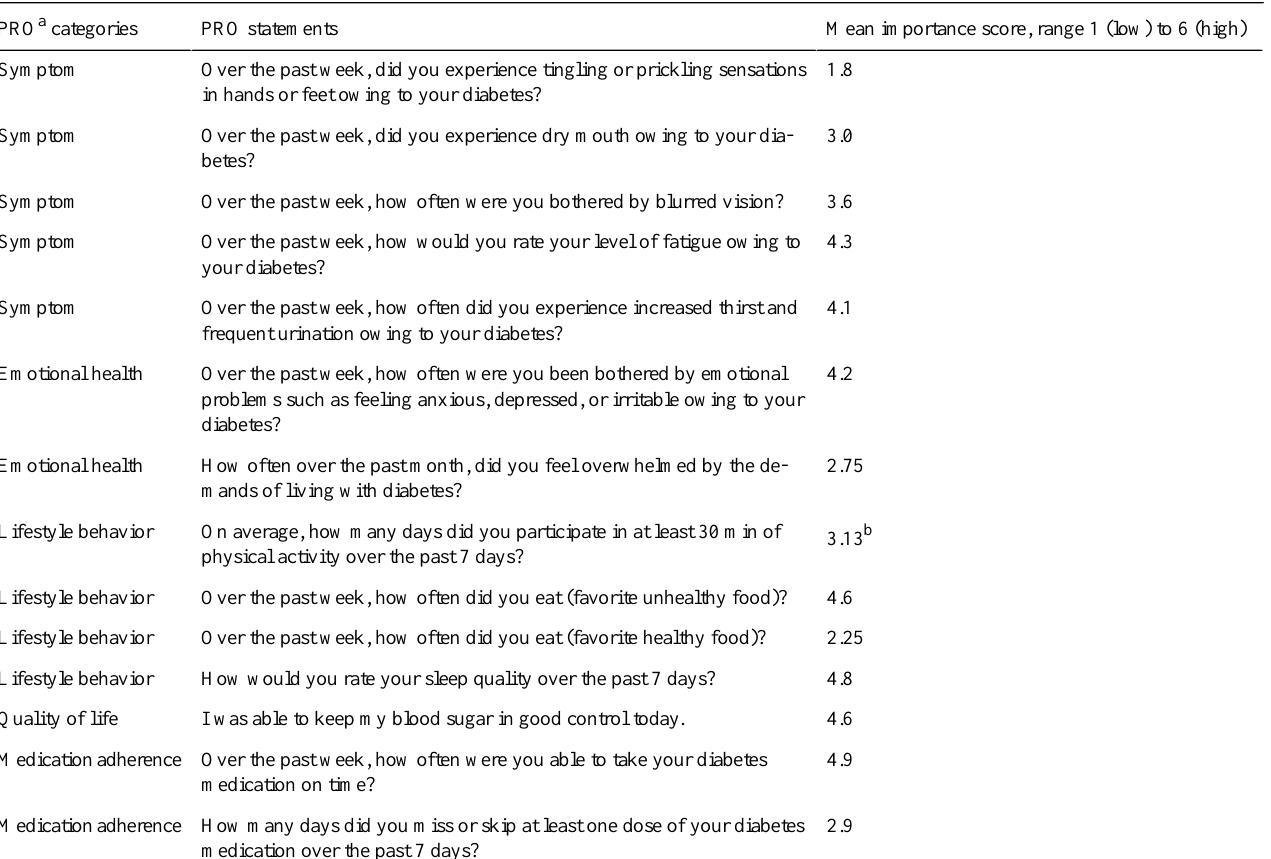
Table 4. Patient ranking of perceived importance of initial list of candidate patient-reported outcomes.